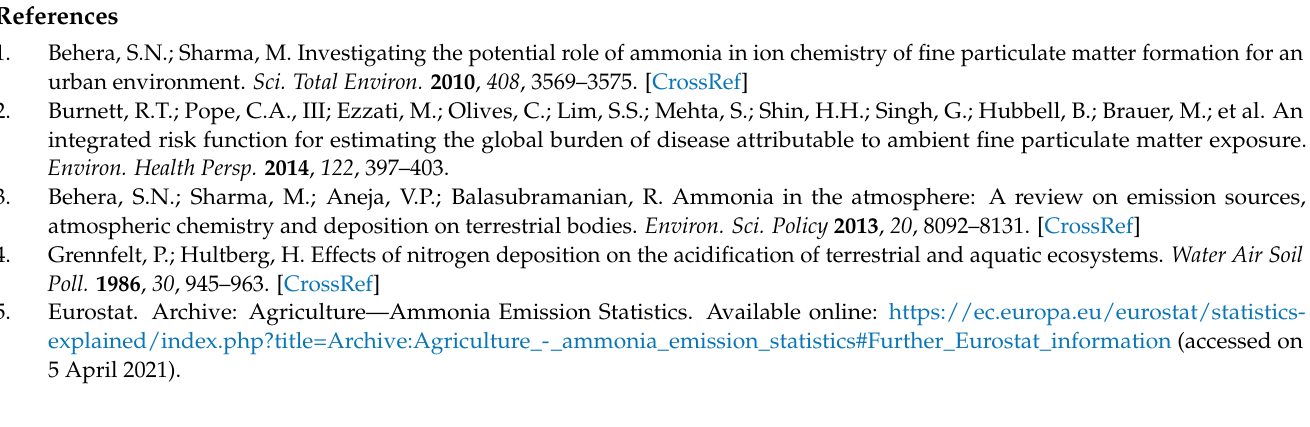
Table S4: The effect of weed management treatment (WMT weedy and WMT weed-free ), nitrogen rate (N 100 and N 50 ), and slurry application method (SA hose , SA shoes , and SA tines+shoes ) on spring barley (SITE A ) and winter wheat (SITE B and SITE C ) grain bulk density, protein, and thousand kernel weight. Data from each site were analyzed separately. A connecting letters report displays differences among treatments, whereby means not sharing a similar letter are significantly different ( p < 0.05). Significant main effects and interactions are highlighted in bold text ( p < 0.05). Standard errors are displayed in parentheses. Figure S1: Prototype combining the operation of a tine and the Bomech trailing shoe, used in SA tines+shoes plots at SITE A . Figure S2: Slurry surface pH following field application of 30 tonne ha − 1 pig slurry to a winter wheat crop growing on sandy loam (EXP NH3.B1 and EXP NH3.B2 ). Standard errors are displayed in bands. Figure S3: Ammonia emissions following field application of 22.8 tonne ha − 1 pig slurry to a spring barley crop on loamy sand (EXP NH3.A ) and 30 tonne ha − 1 pig slurry to a winter wheat crop on sandy loam (EXP NH3.B1 and EXP NH3.B2 ). Standard errors are displayed in bands. Figure S4: Image of soil conditions at SITE B and SITE C , featuring substantial crusting and cracking. Video S1: Slow motion video of the Vogelsang trailing shoe operating in SA shoes plots at SITE B and SITE C . Video S2: Slow motion video of the prototype combining the operation of a tine and the Vogelsang trailing shoe operating in SA tines+shoes plots at SITE B and SITE C . Video S3: Slow motion video of hoses operating in SA hose plots at SITE A , SITE B , and SITE C